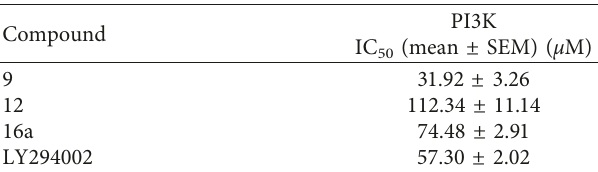
Table 3: Inhibitory activities of compounds 9 , 12 , and 16a against